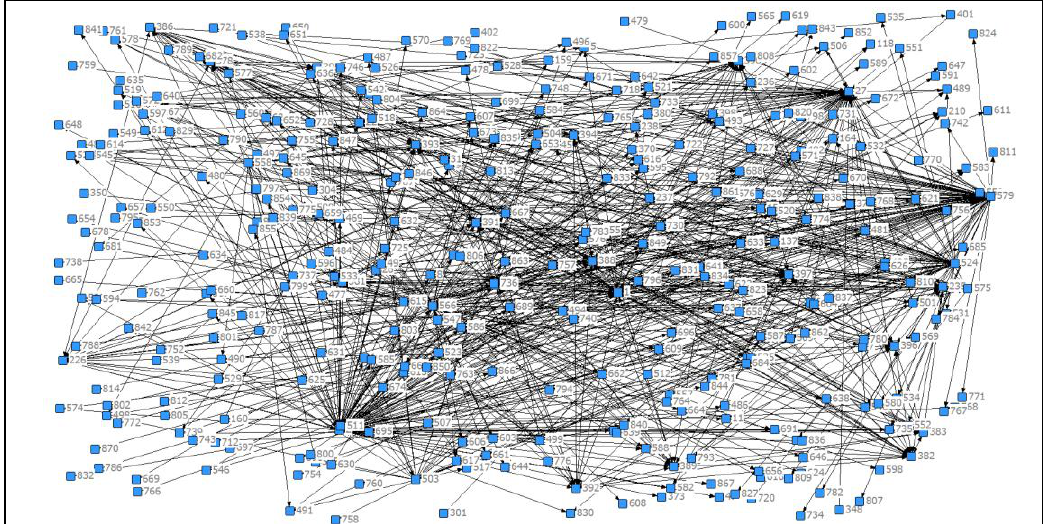
Figure 8 . Original network interaction on the CoCoing.info.